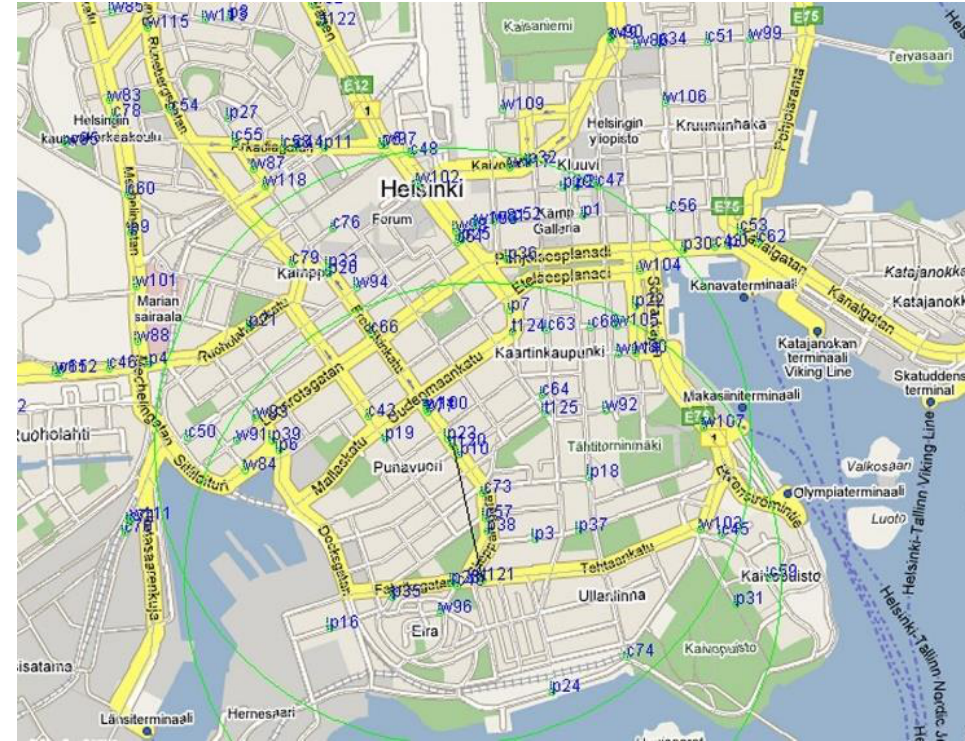
Figure 3. Simulation map in Helsinki.